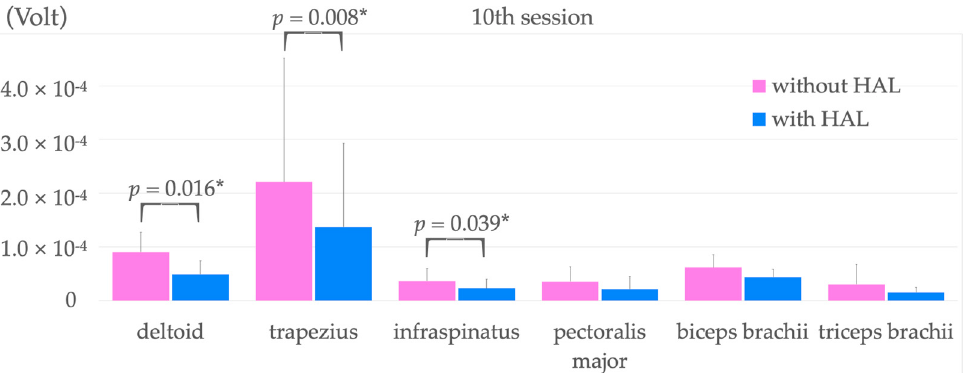
Figure 5. Comparison of surface EMG activity during upper limb raising before and after HAL application in the tenth training intervention session. * p < 0.05. HAL, hybrid assistive limb.